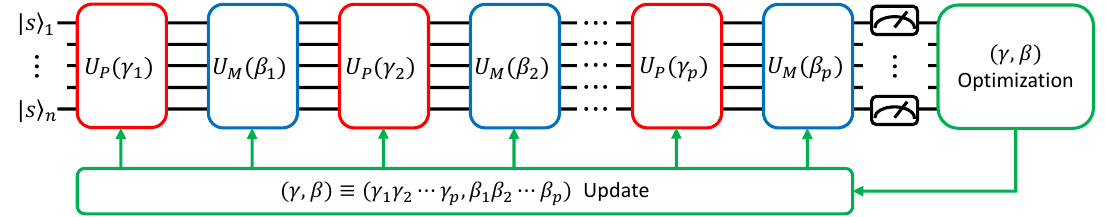
Figure 1. Quantum approximate optimization algorithm (QAOA) circuit with the classical optimization loop part.